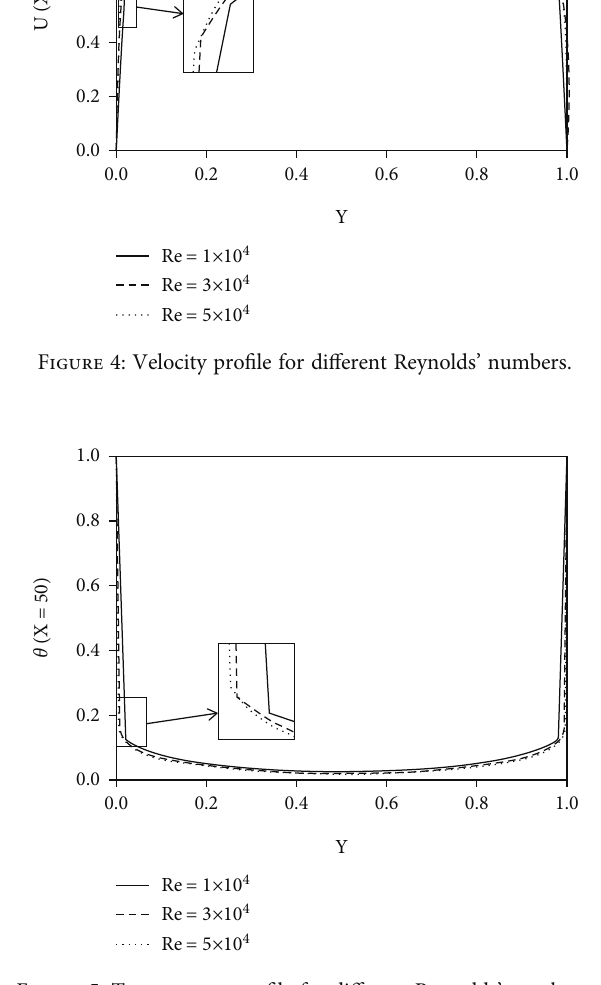
Figure 5: Temperature pro fi le for di ff erent Reynolds ’